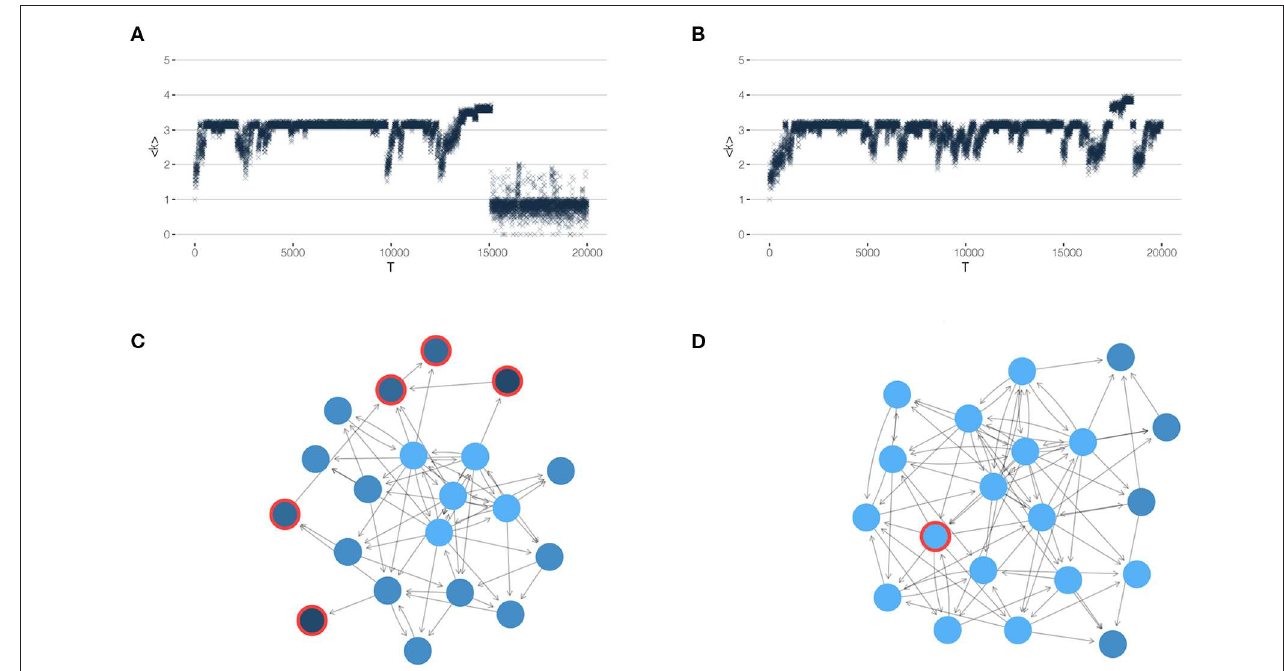
FIGURE 5 | Results of network interventions. (Left) control of many peripheral agents, (Right) control of one agent close to the core. (A,B) show the mean coreness h k i and the number of agents leaving, N ex over time T , to be compared to Figure 4 . (C,D) Snapshots of the network at a particular time T , when the cost c 0 of the agents circled in red is